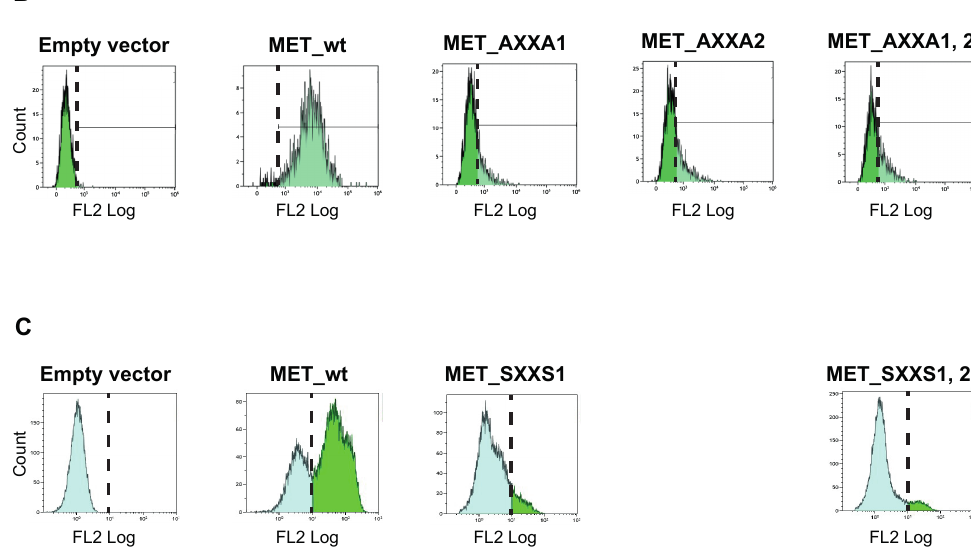
Figure 4. The MET CXXC mutants are blocked in the Golgi apparatus. ( A ) TOV112D cells stably expressing indicated receptors were stained with MET antibodies (red pseudocolor) and 58 K Golgi protein antibodies (yellow pseudocolor). DAPI staining was performed to visualize the nuclei (grey). Images were acquired with the Leica TCS SP8 confocal microscope and post-processed with ImageJ. Pictures are representative of two independent experiments. Arrows in the merged images denote Golgi gathering of the signal. ( B ) TOV112D cells stably expressing wt_MET or AXXA mutants of MET in indicated CXXC motifs were assessed for surface MET expression by flow cytometry. The dashed line indicates the background signal threshold determined in MET negative TOV112D cells. ( C ) HEK293T cells were transiently transfected with wt_MET or SXXS mutants and analyzed as above. In the latter cell line, the MET antibody recognizes both the endogenous (left blue peak superimposable to the peak observed in cells transfected with an empty vector) and transfected MET wild-type or mutant proteins (right green peak). The two peaks are separated with dashed lines.